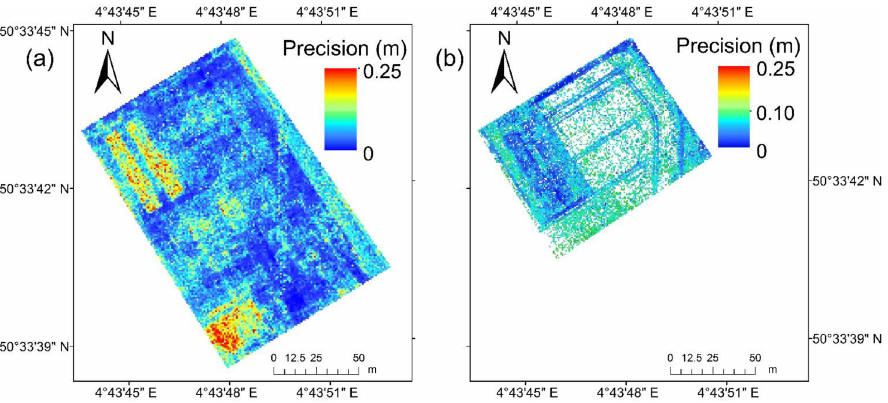
Figure A3. Monte Carlo Precision maps. (a) Dataset: down-sampled DSLR images with equal GSD as action camera images. (b) Dataset: clipped action camera images with equal FOV. Note: the additional action camera flight mission (right) was conducted 1 year later and the surface had slightly changed, but there was a spatial